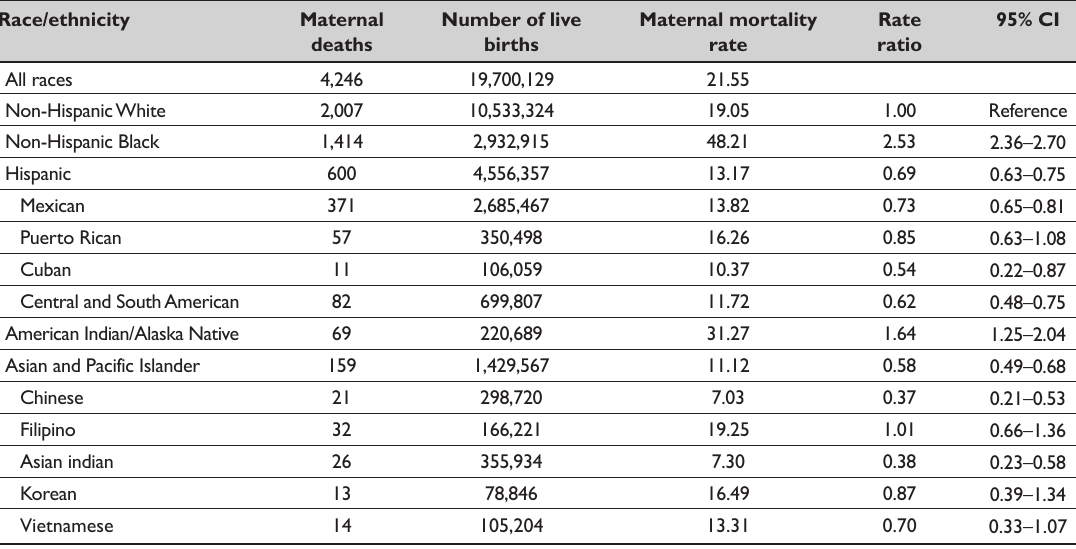
Table 1: Maternal mortality rates per 100,000 live births by race/ethnicity, United States, 2013-2017